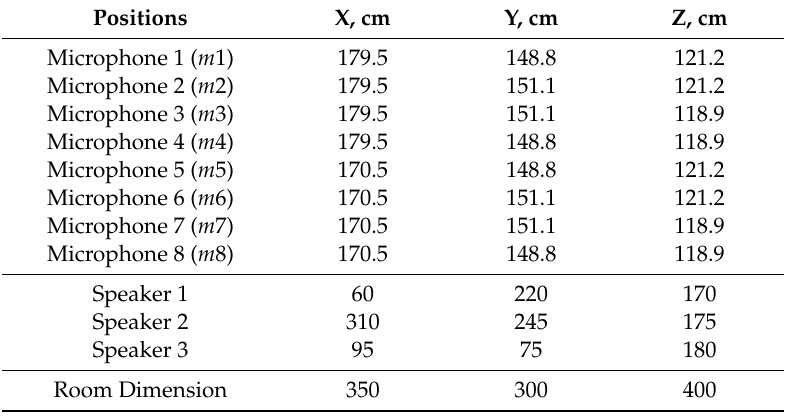
Figure 9. A view of the simulated room with the locations of the speakers and microphone array. Table 1. Microphones positions, speakers’ locations and room dimension.